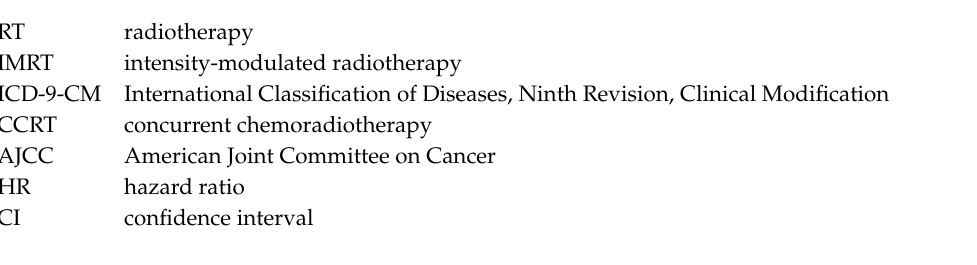
Table S1: Characteristics of patients with TESCC receiving CCRT with intensity-modulated radiation therapy or three-dimensional conformal radiation therapy (AJCC clinical stages presented with TN system), Table S2: Cox proportional hazard regression analysis of mortality risk among patients with TESCC receiving CCRT (AJCC clinical stages presented with TN system), Table S3: T and N-stage-stratified Cox proportional hazards model for mortality risk associated with treatment modalities in patients with TESCC receiving CCRT. Table S4: Characteristics of patients with TESCC receiving CCRT with IMRT or 3D-CRT and their propensity score–matched cohort. Table S5: Cox proportional hazard regression model for mortality risk among patients with TESCC receiving CCRT in their propensity score–matched